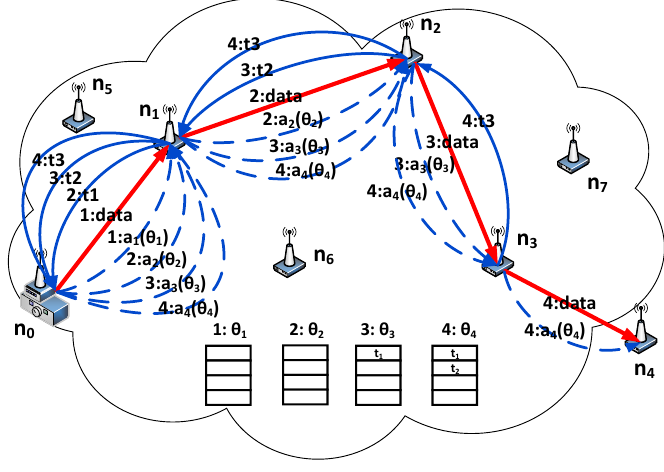
Figure 6. Transmission mechanism of replay memory in joint design scheme.